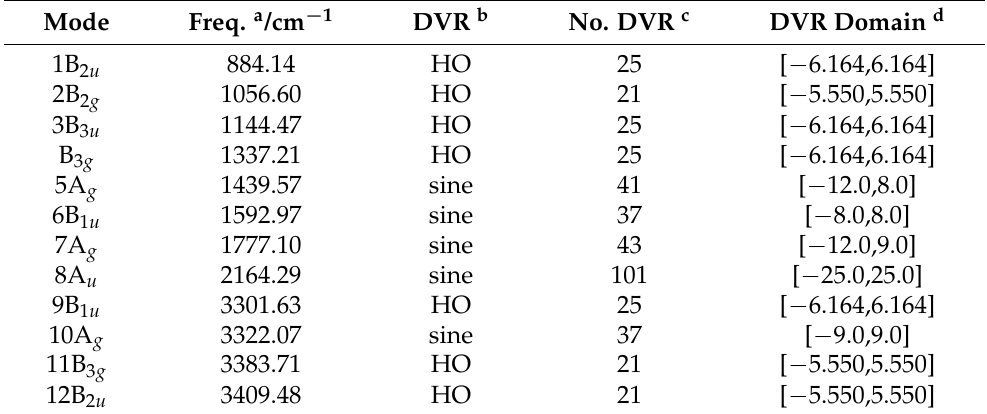
Table 5. Details of the normal modes, DVR bases and initial wavepacket conditions used in the initial 12D ethene calculation. ( a ) Frequencies of the normal modes calculated at the minimum energy geom- etry of the electronic ground state. ( b ) Type of underlying basis functions used to generate the DVR bases: sine denotes eigenfunctions of the 1D particle-in-a-box and HO refers to the eigenfunctions of the harmonic oscillator problem. ( c ) Number of DVR gridpoints for each mode. ( d ) Locations of the initial and final DVR gridpoints along each mode. Note that the sine DVR gridpoints are evenly spaced whilst the HO points are not, being more concentrated towards the